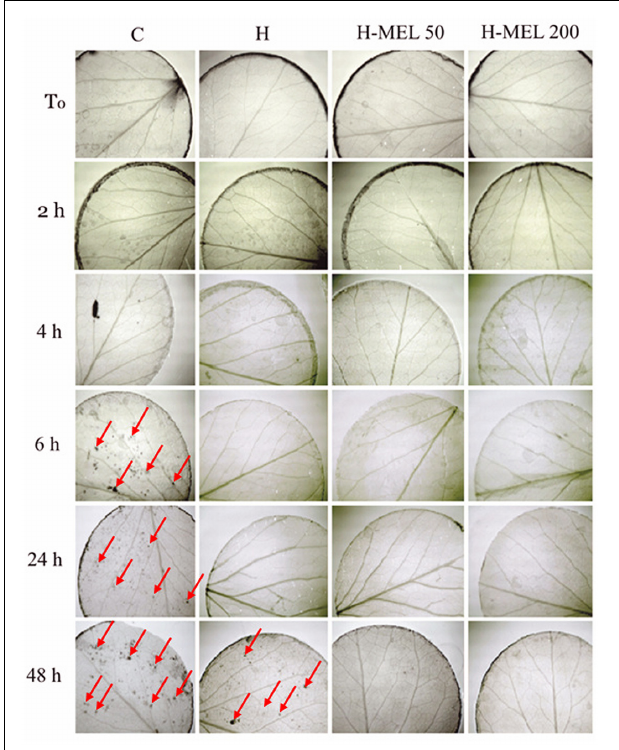
FIGURE 4 | Detection of O •− in leaf disks of 24-day-old pea plants 2 grown from the control (C), hydroprimed (H), and hydroprimed with an aqueous solution of 50 µ M melatonin (H-MEL50) or 200 µ M melatonin (H-MEL200) seeds. Photographs were taken at T 0 (before PQ treatment) and after 2, 4, 6, 24, and 48 h of disk incubation in 75 µ M PQ solution. Red arrows indicate dark spots of formazan derived from NBT oxidized by O •− 2